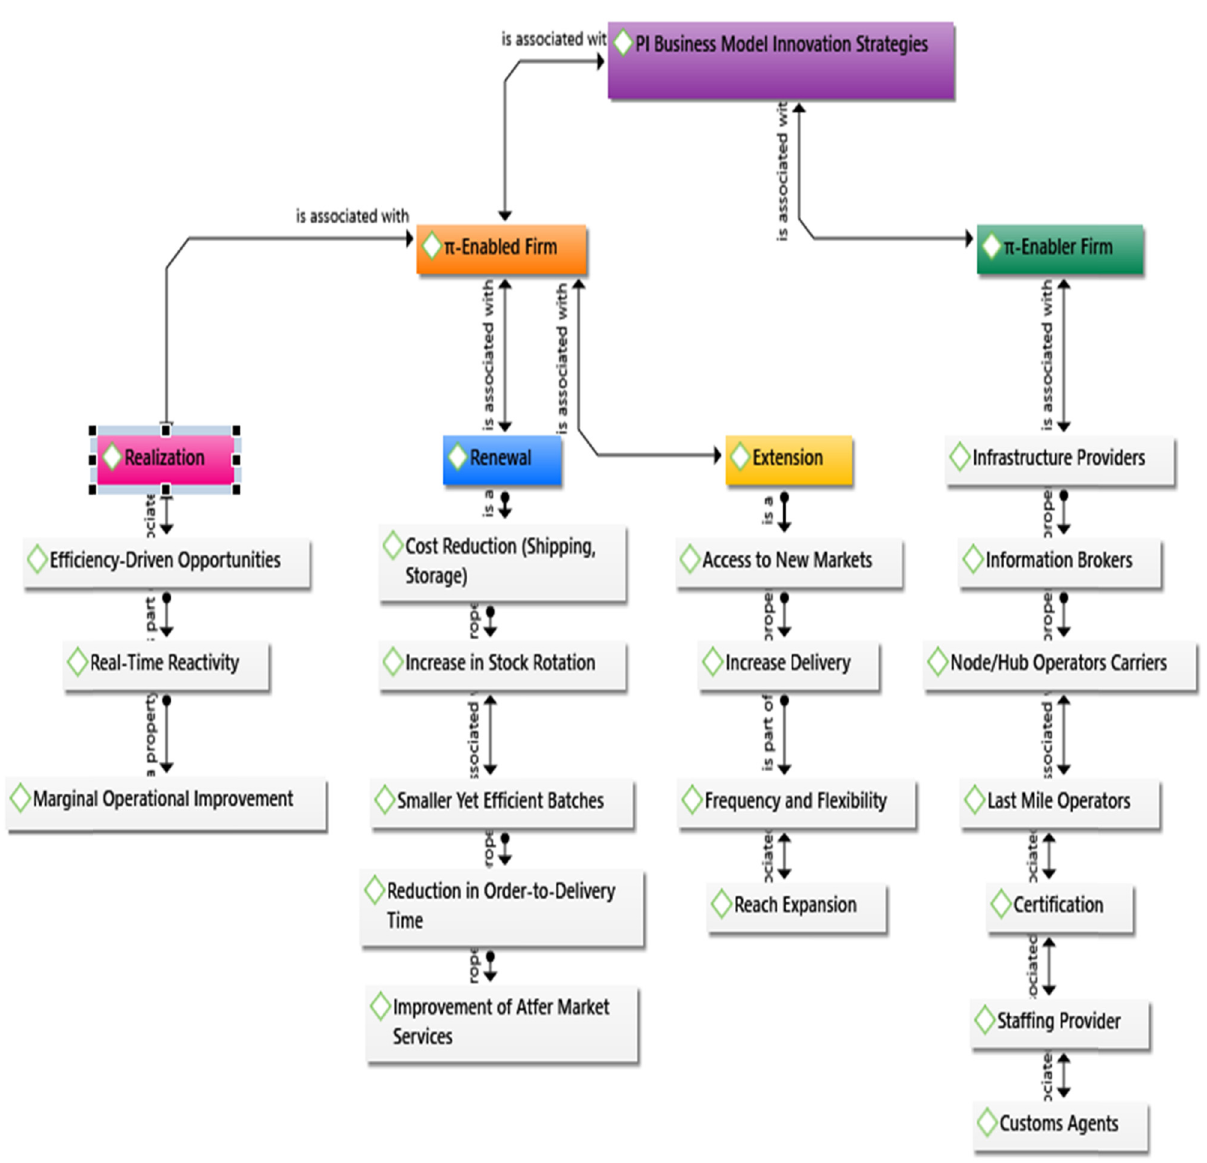
Figure 6: ATLAS.ti network view on PI business model innovation